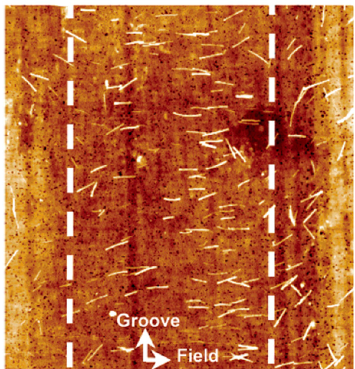
Figure 6. Controlling the orientation of a Multiwalled Carbon Nanotube (MWCNT) by an electric field: The two dashed lines are the copper electrodes to apply the electric field perpendicular to the surface microgrooves (for an initial alignment parallel to them). When the electric filed is above 1.8 V µ m − 1 , the CNTs reorient along the field direction [14].